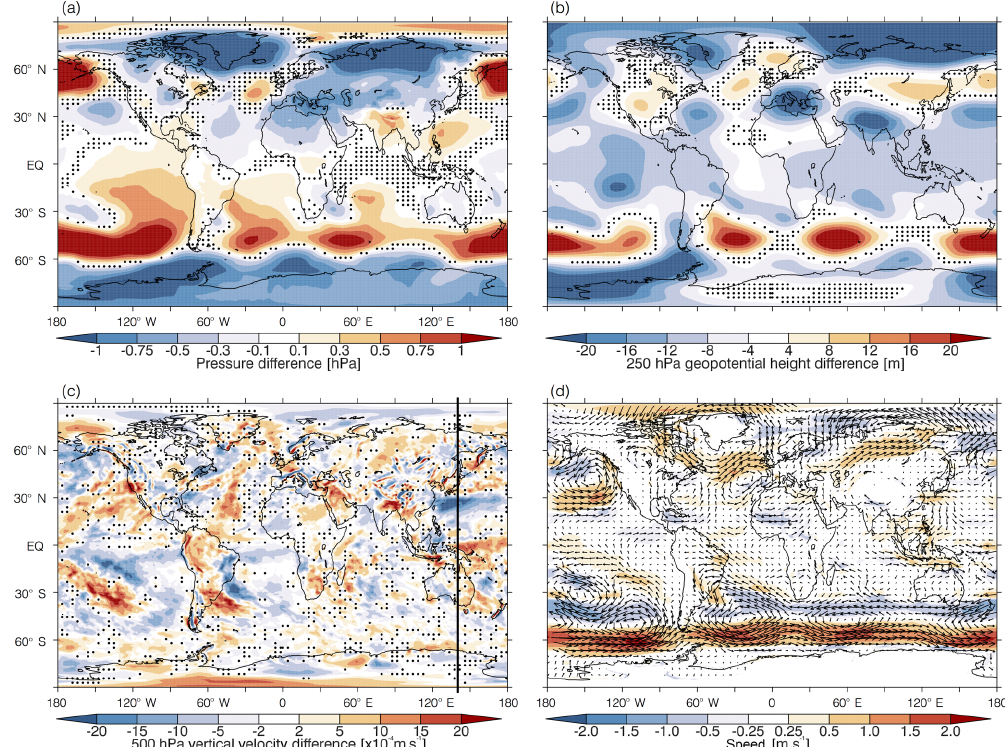
Figure 5. Ensemble mean, (1998–2012) vs. (1979–1993), difference in (a) sea level pressure, (b) 250hPa geopotential height, (c) 500hPa vertical velocity, and (d) 850hPa wind. Dots indicate where the response is not significant at the 10% level, as calculated using a two-tailed Student’s t test (note that there is no indication of significance in panel d ). Figure 6a and b show the agreement of individual ensemble members on the sign of the geopotential height anomaly shown in panel (b) . The black line in panel (c) is at 140 ◦ E and indicates the location of the transect shown in Fig.